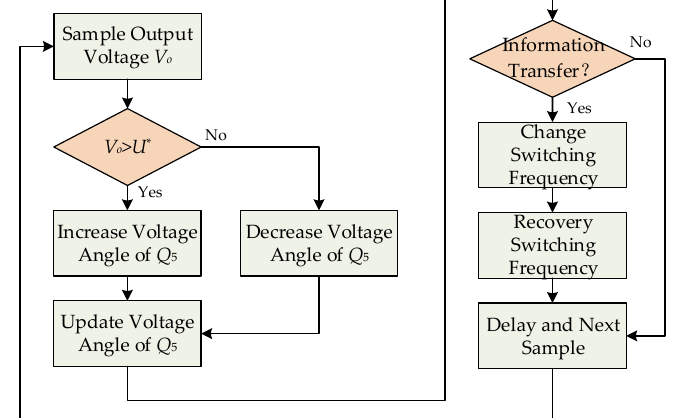
Figure 10. Flow chart of control algorithm.